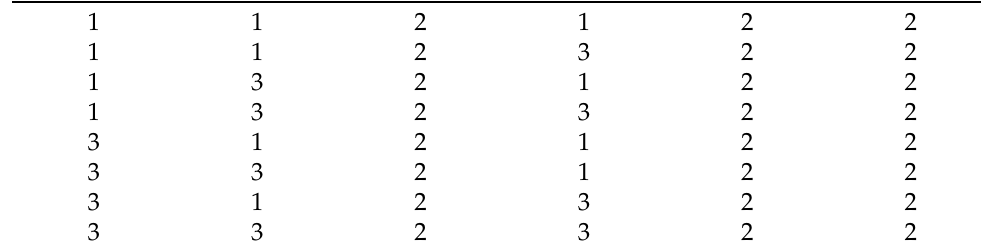
Table A7. Box–Behnken’s